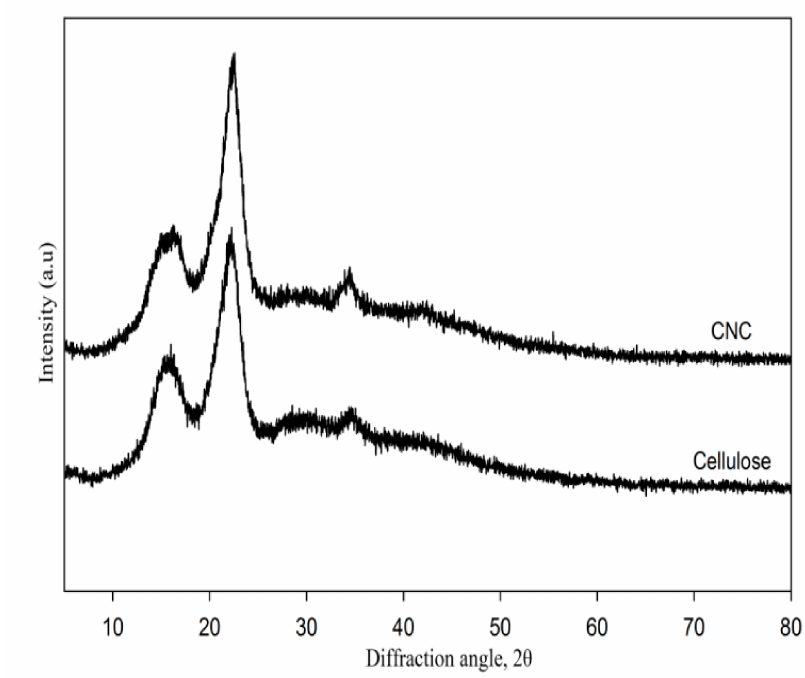
Figure 2. X-ray diffraction patterns of cellulose and CNCs.